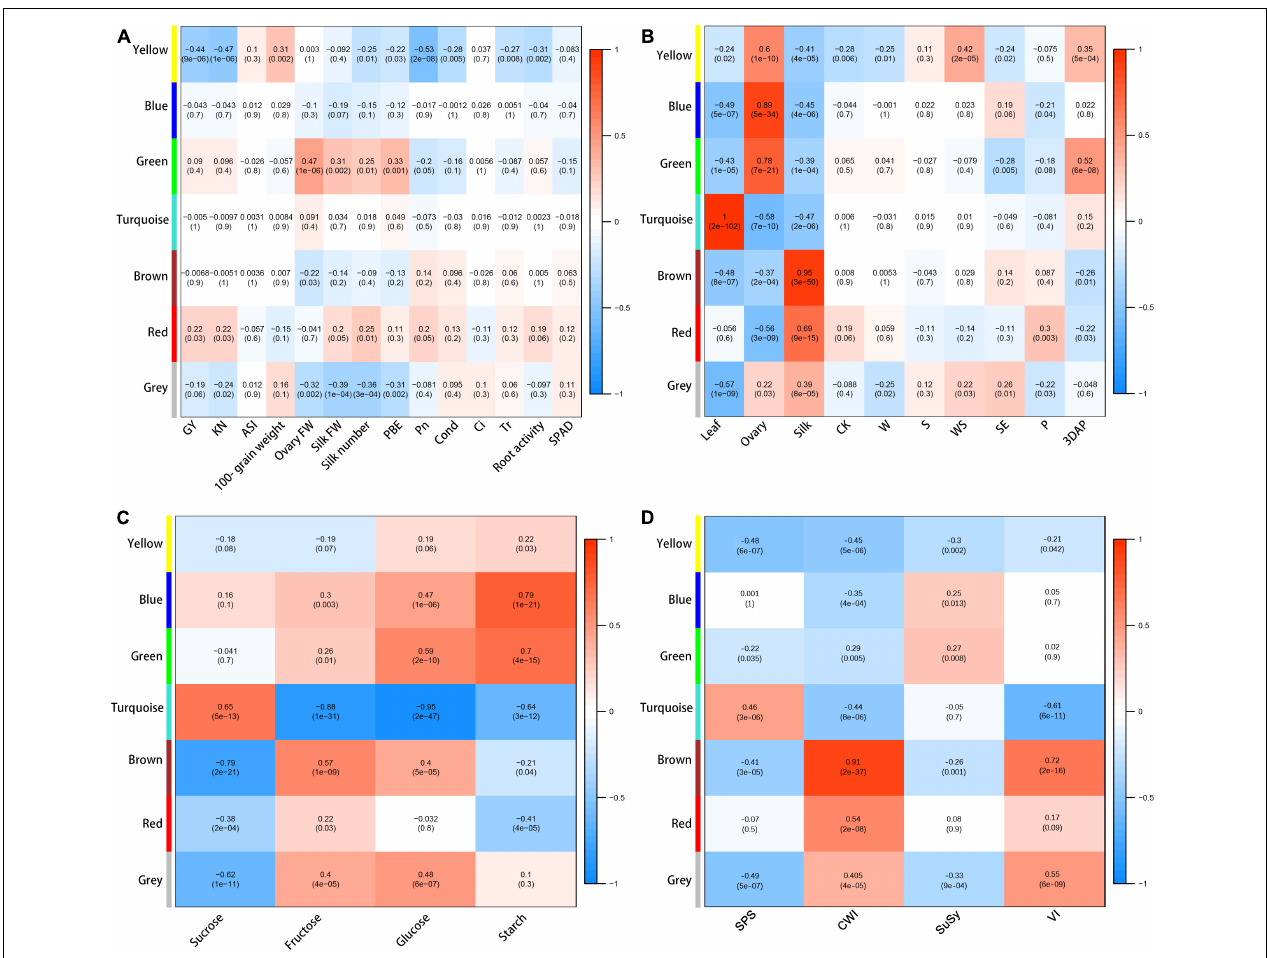
FIGURE 6 | Heat map and Pearson’s correlations with between modules and agronomic and physiological traits (A) , organs or treatments (B) , sugar contents (C) , and enzymatic activity (D) . Gray modules represent metabolites that cannot be categorized.